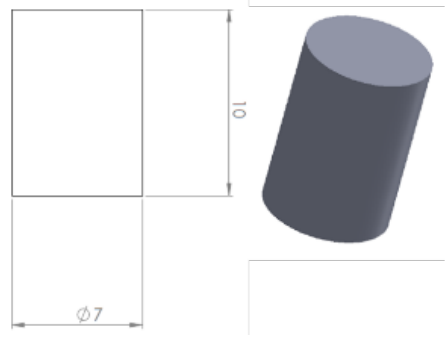
Figure 2. Compression test specimen shape and geometry in mm. Table 1. Chemical composition of “D2” and “O1” tool steels in mass percent (%).